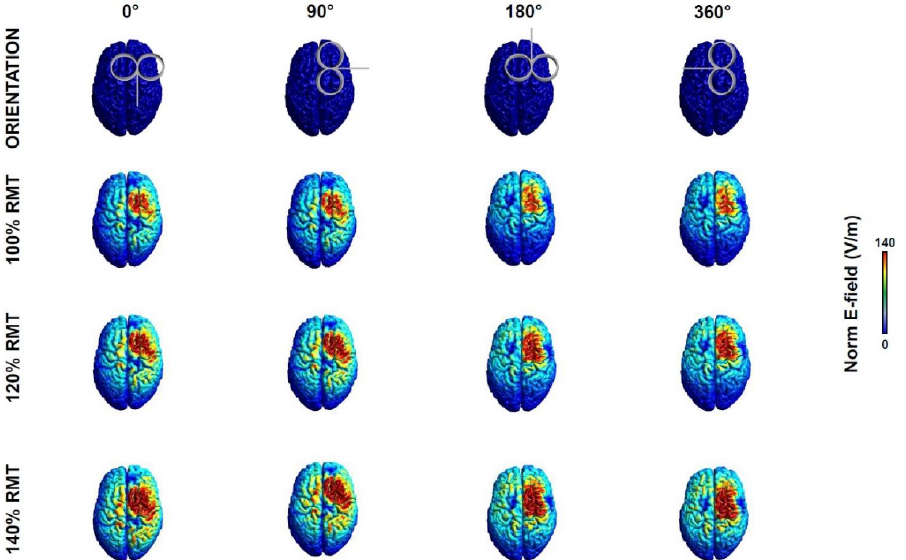
Figure 3. Pictorial representation of the E–field induced by TMS in the 12 conditions explored (see text for details).